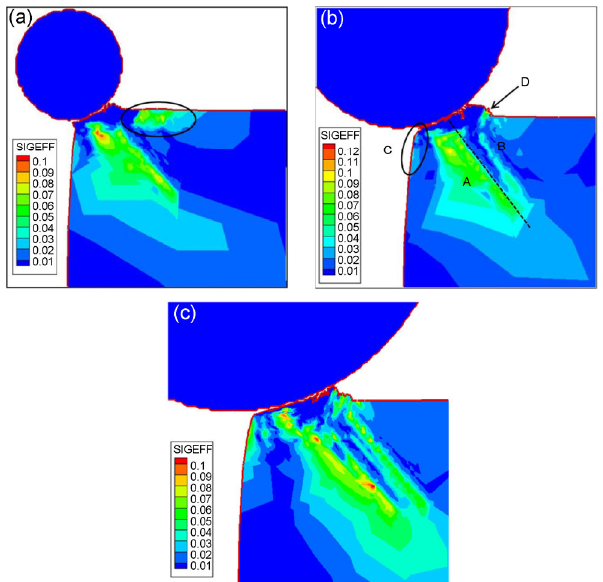
Fig. 9 Stress diagrams at the 70 th load step with particle radius of (a) 5 nm, (b) 10 nm, and (c) 20 nm.